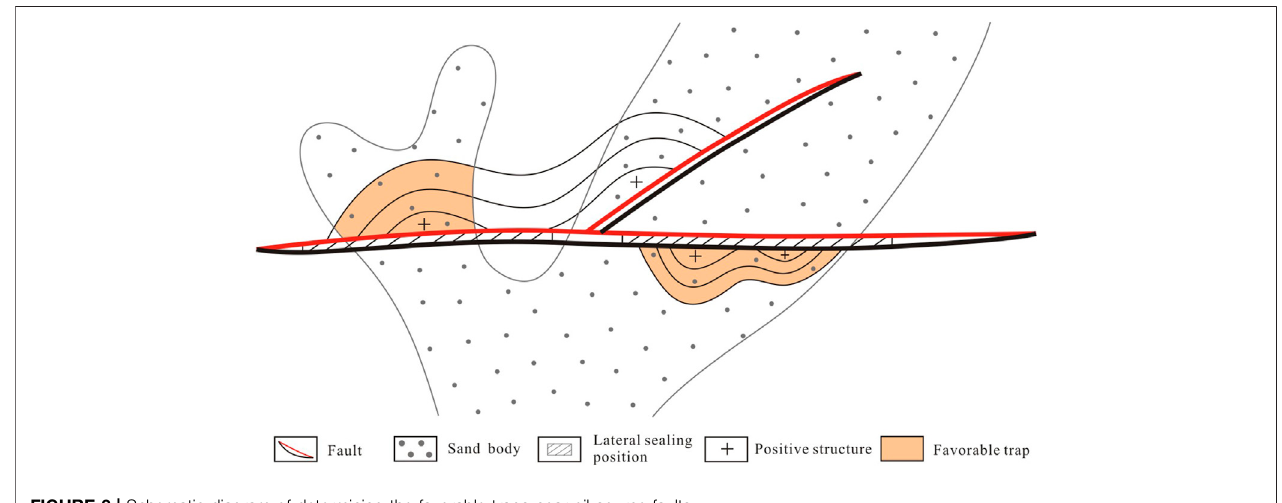
FIGURE 3 | Schematic diagram of determining the favorable traps near oil-source